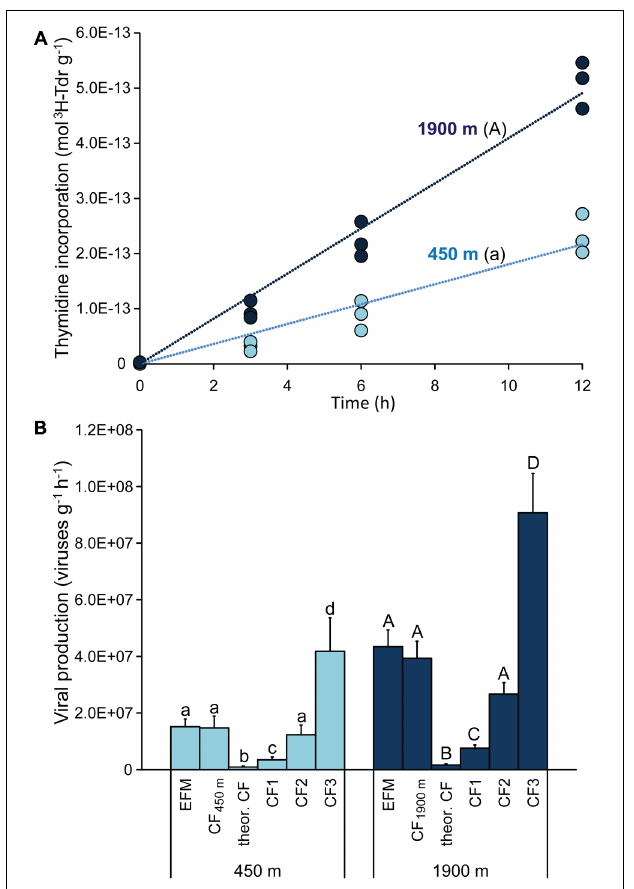
FIGURE 3 | (A) Shows values of incorporation of tritiated thymidine into viral DNA obtained during time course incubation experiments carried out on sediment samples collected at the two benthic deep-sea sites. The upper case letter “A” for the station at 1900 m indicates that the incorporation rate of 3 H-thymidine was significantly higher ( p < 0.01) than at 450 m water depth (marked with lower case letter “a”). (B) Reports the comparison of viral production rates obtained by the EFM method with those estimated based on the 3 H-thymidine method using different CFs. These include: (i) the sample-specific CFs determined for the two stations analyzed in the present study (CF 450m , and CF 1900m ) of, respectively, 0.74 × 10 21 and 0.91 × 10 21 viruses produced per mole of 3 H-thymdine incorporated; (ii) the theoretical CF of 0.024 × 10 21 viruses mol − 1 (Noble and Steward, 2001); and (iii) the CFs empirically determined in previous studies (CF1, CF2, and CF3) of, respectively, 0.175 × 10 21 (Danovaro et al., 2008b), 0.617 × 10 21 (Steward et al., 1992), and 2.1 × 10 21 (Steward et al., 1992) viruses mol − 1 . Different letters indicate significant differences ( p < 0.01) among the values obtained using different CFs, and upper case letters for the station at 1900 m water depth indicate significant differences ( p < 0.01) compared with the corresponding values reported for the station at 450 m water depth.